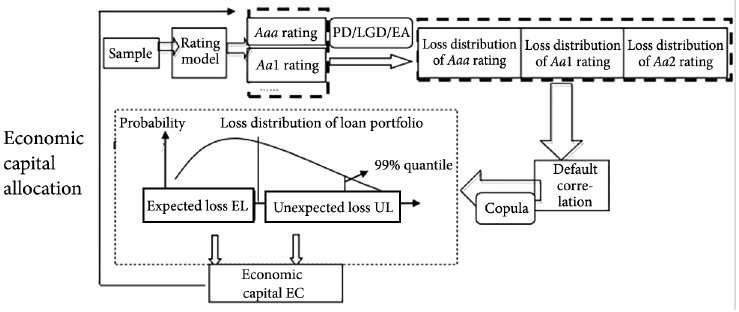
Figure 2. The estimation procedure of economic capital (source: own